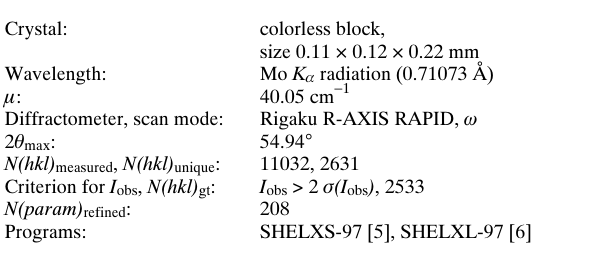
Table 1. Datacollection and